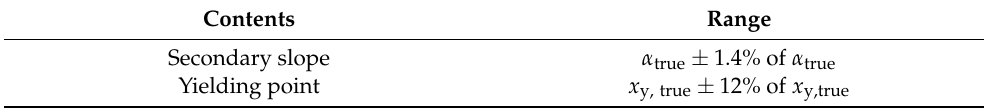
Table 7. Parameter range for the simplified nonlinear model.